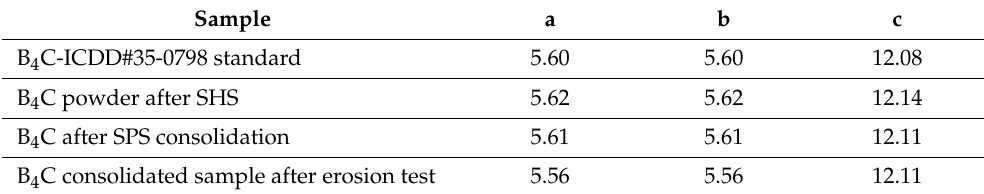
Table 3. Lattice parameters for boron carbide (calculated for hkl = 021 peak).